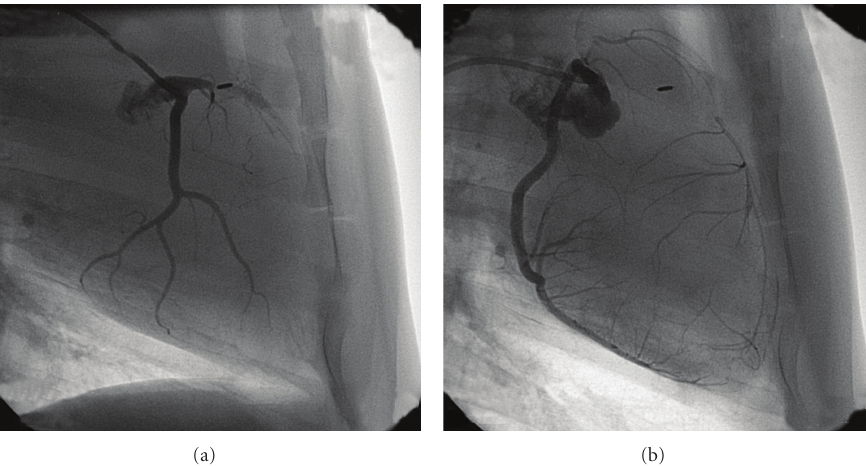
Figure 1: Coronary angiography at 2 months. (a) Totally occluded left anterior descending artery with bridge collateral flow . (b) Rentrop degree 2 collateral flow from right coronary artery to left anterior descending artery.